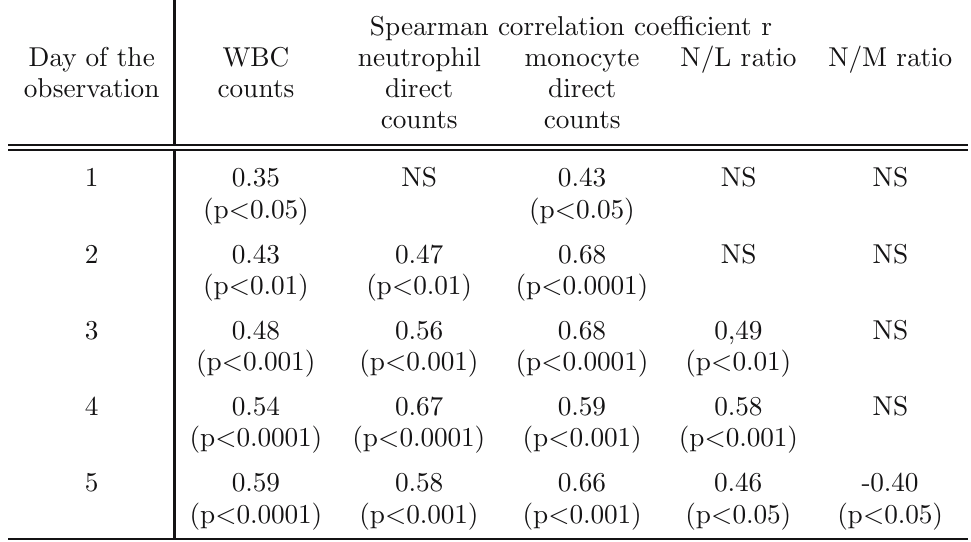
Table 2 Correlations of total WBC counts with CRP plasma levels in AP